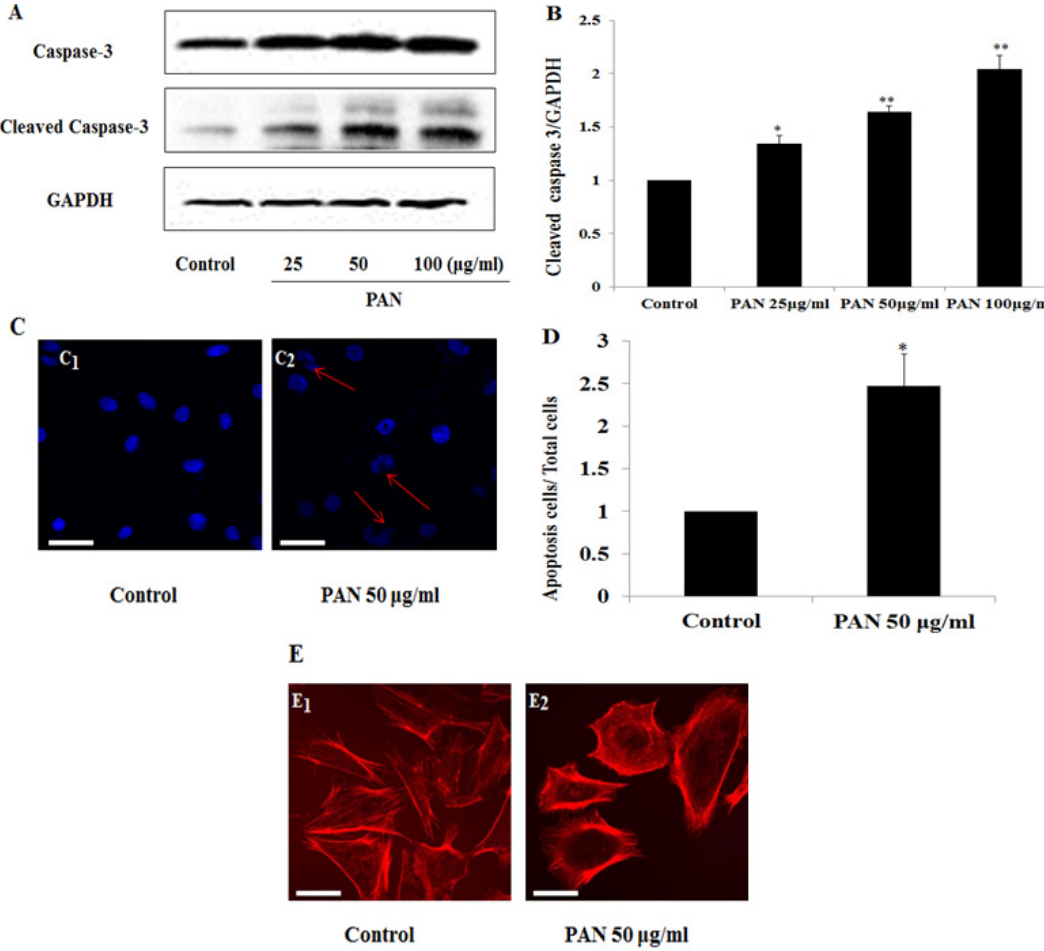
Figure 2. Injury of podocyte after PAN treatment 24 h. ( A ) Cell lysates were analyzed via western blot with antibodies against caspase 3, cleaved caspase 3 and GAPDH, respectively; ( B ) The amounts of protein were quantified and calibrated with the expression of GAPDH; ( C ) Images of podocytes stained with Hoechst (400×, original magnification). Hoechst staining demonstrates nuclei of apoptosis cells and living cells. Red arrows represent apoptotic cells. Bar = 40 μ m; ( D ) Quantitative analysis of apoptosis cells presents as apoptosis cells/total cells; ( E ) F -actin staining with the fluorescence study (red color). Bar = 40 μ m. Data are presented as mean ± SD. n = 3. * p < 0.05, ** p <